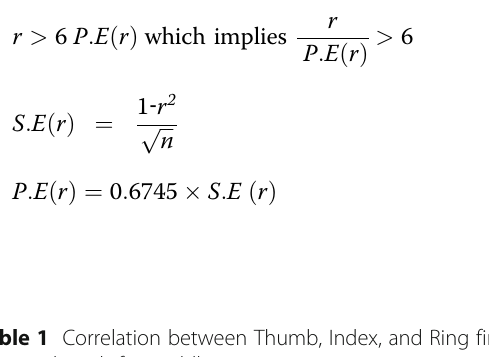
Table 1 Correlation between Thumb, Index, and Ring